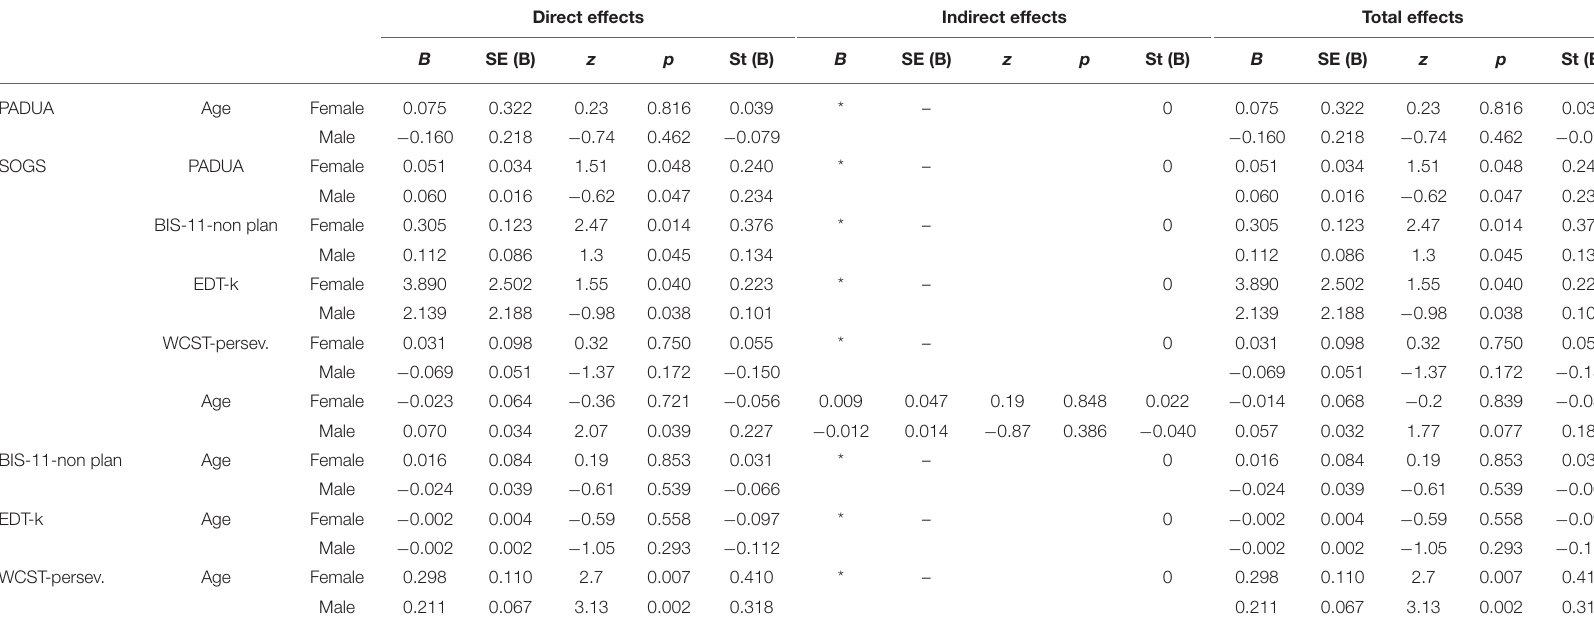
TABLE 3 | Structural Equation Modeling: direct, indirect and total